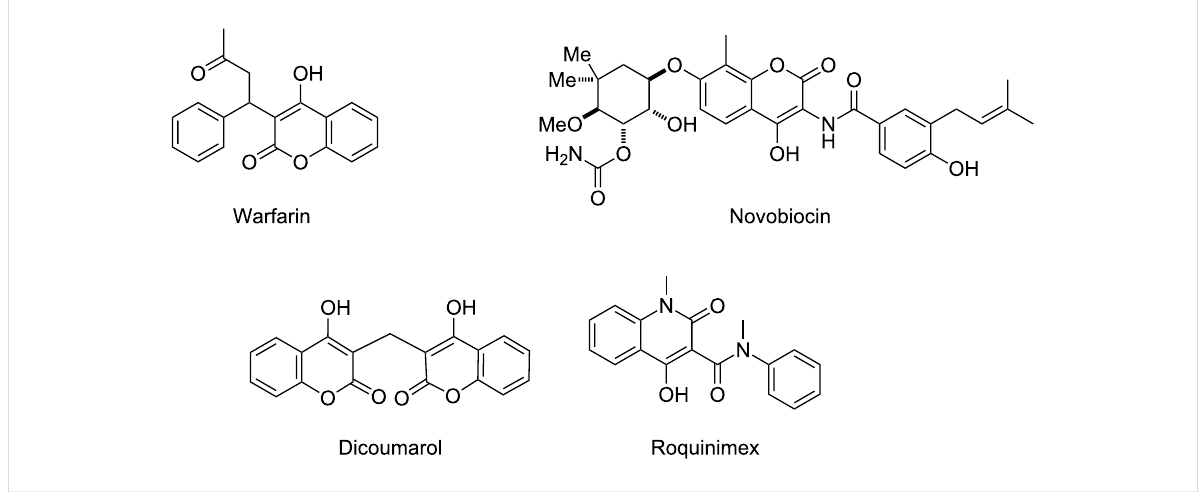
Figure 1: Selected examples for biologically active 4-hydroxy-2 H -chromen-2-one and 4-hydroxy-2(1 H )-quinolinone compounds.